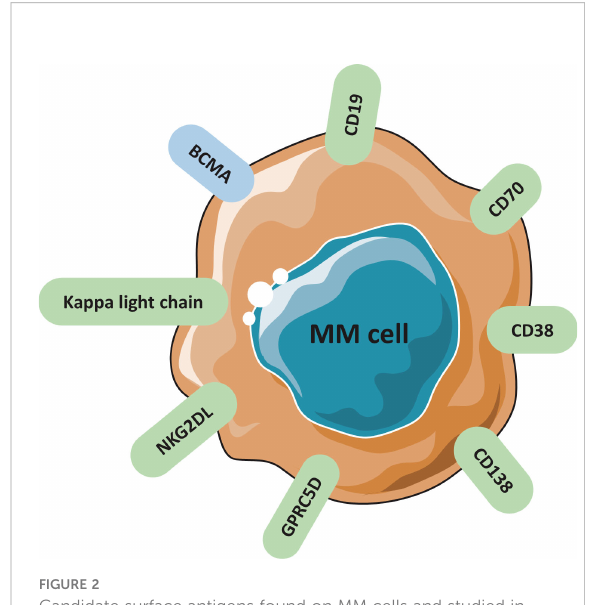
FIGURE 2 Candidate surface antigens found on MM cells and studied in clinical